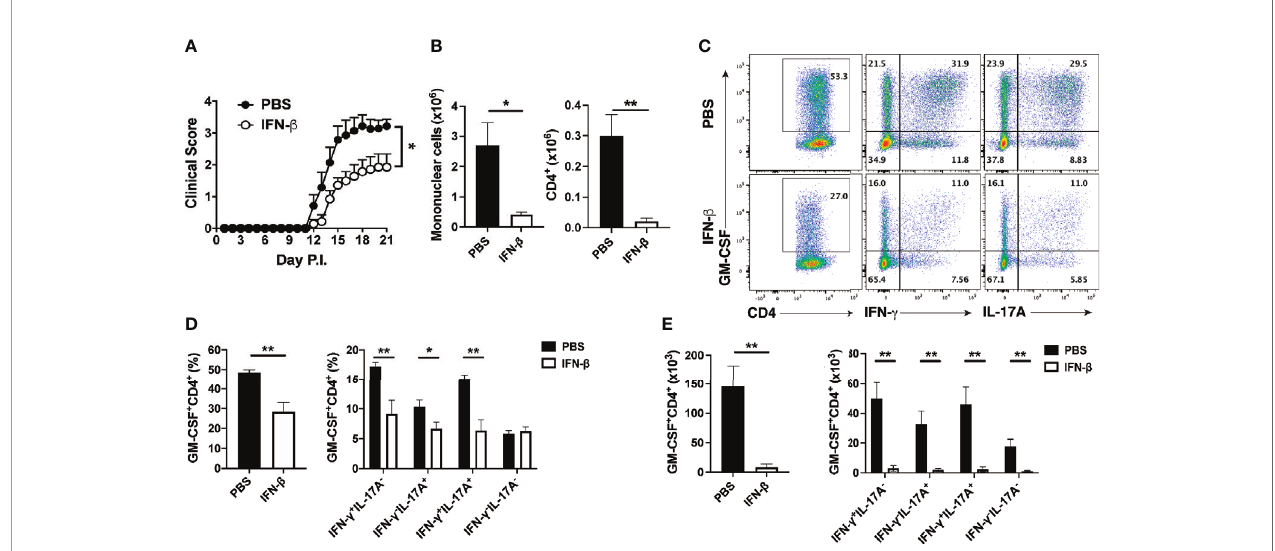
FIGURE 1 | rIFN- b decreases the numbers of GM-CSF-producing Th cells in the CNS of mice with EAE. Female C57BL/6 mice (n=7 per group) were immunized for EAE induction with MOG 35-55 and received daily intraperitoneal (i.p.) injections of PBS or rIFN- b (30000 IU). Mice were scored daily for clinical signs and sacri fi ced at disease peak (day 15 p.i.), and CNS mononuclear cells were analyzed by fl ow cytometry. (A) Clinical severity score. (B) Total numbers of CNS mononuclear cells and CD4 + T cells in the CNS at day 15 p.i. (C) Representative fl ow cytometry dot plots showing GM-CSF, IFN- g , and IL-17A expression by CD4 + T cells in the CNS at day 15 p.i. (D) Proportions and (E) total numbers of GM-CSF + CD4 + , and different subsets of GM-CSF + CD4 + T cells in the CNS. These experiments were conducted twice with similar outcomes. Data shown are mean ± SEM. For EAE, p-values were calculated using two-way ANOVA with Bonferroni ’ s multiple comparison correction. Parametric datasets were analyzed using unpaired Student ’ s t -test; *p < 0.05, **p < 0.01.